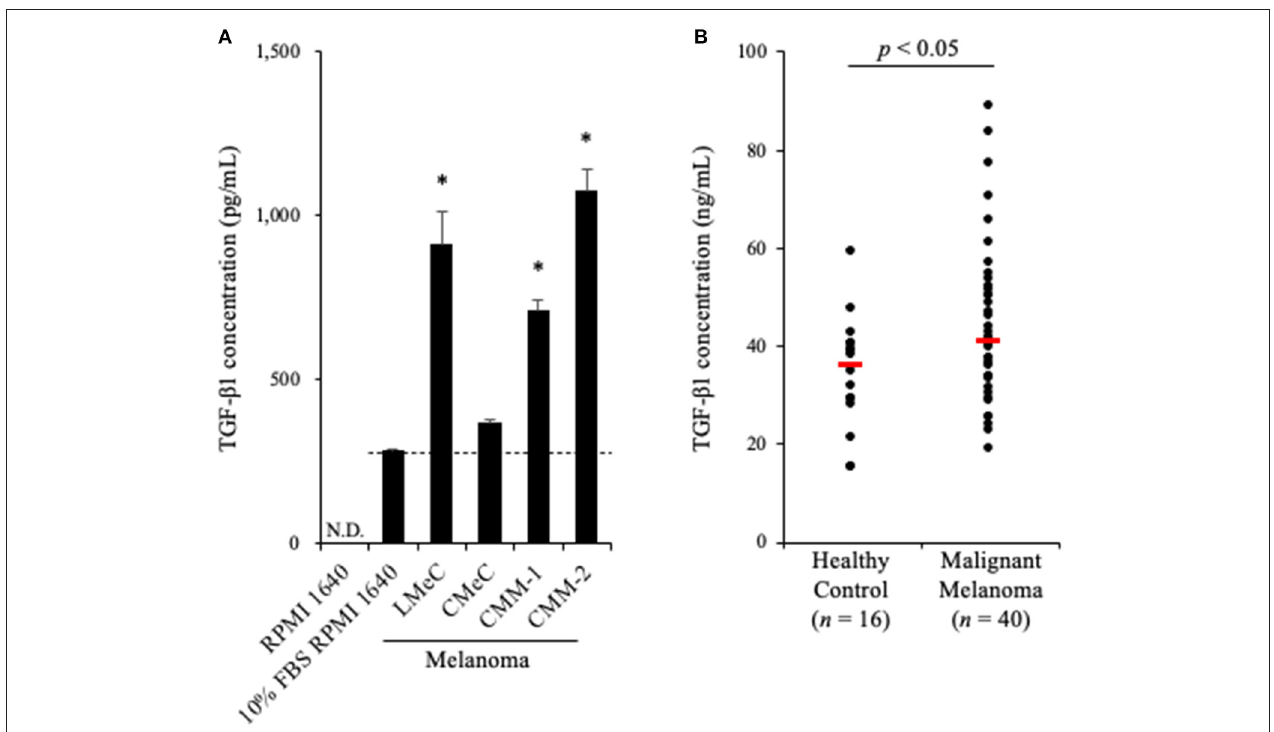
FIGURE 1 | TGF- β 1 expression in canine cancers. (A) TGF- β 1 production by canine cancer cell lines. TGF- β 1 concentration in 10% FBS RPMI 1640 is shown as the background (a dashed line). One-way ANOVA with post-hoc Dunnett’s-test was used for statistical analysis under the assumption of equal variance between samples (* p < 0.05 vs. 10% FBS RPMI 1640). (B) TGF- β 1 serum levels in dogs with oral malignant melanoma. The red bar shows the median value. The Mann-Whitney U -test was used for statistical